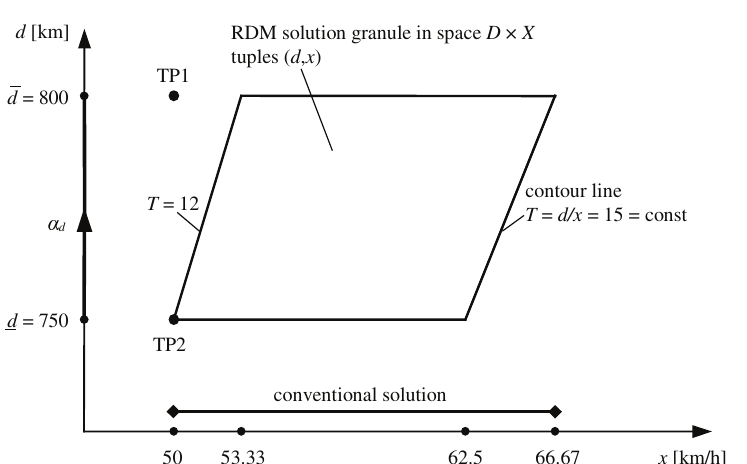
Fig. 8. Nonrectangular solution granule of the equation d / x = T in the 2D-space ( D × X ) ; TP1 and TP2 – test